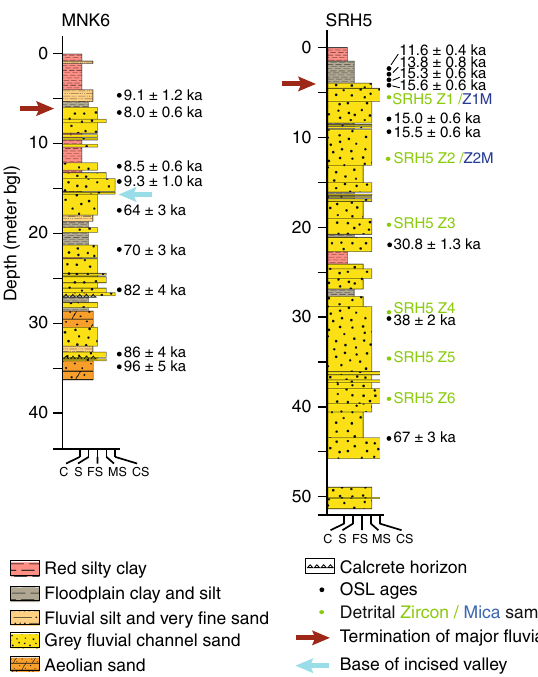
Grain size scale: C, clay; S, silt; FS, fine sand; MS, medium sand; CS, coarse sand Fig. 8 Core stratigraphy, sedimentology and OSL ages at MNK6 and SRH5 drill sites along Ghaggar – Hakra palaeochannel. Sampling points for U-Pb detrital zircon and 40 Ar/ 39 Ar detrital muscovite analysis are also indicated. Arrows indicate basal fl uvial erosion surface (red) and base of incised valley (blue). Note major age disjunction at 16 m depth in core MNK6, indicating a major episode of fl uvial incision and de fi ning the base of the incised valley. bgl below ground